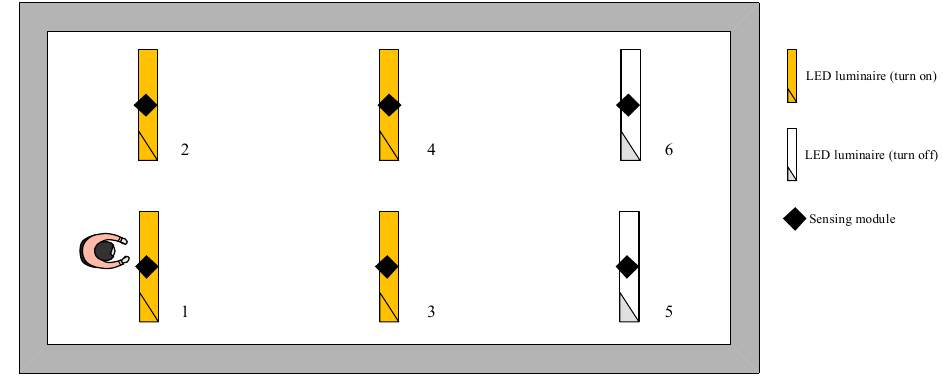
Figure 2. A simple example of lighting control according to occupancy information with neighbor assistance.